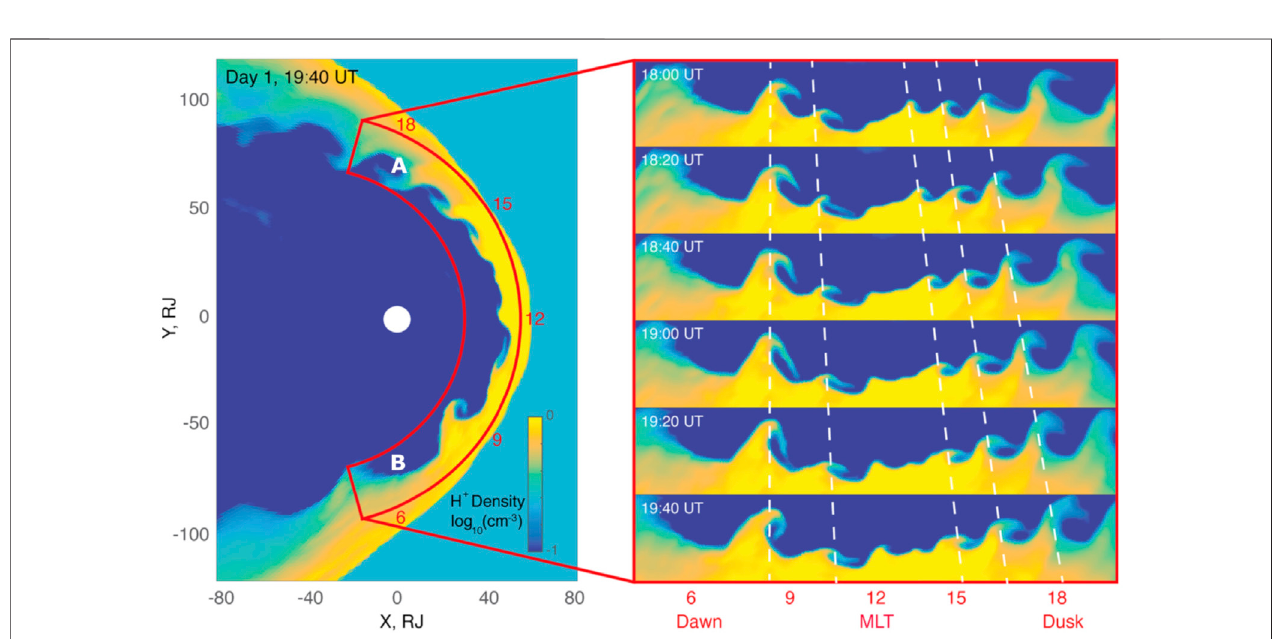
FIGURE 2 | Multi fl uid Lyon-Fedder-Mobarry simulation of Jupiter ’ s magnetosphere showing KH waves on the dayside magnetopause boundary due to internal corotational fl ows (Zhang et al., 2018).